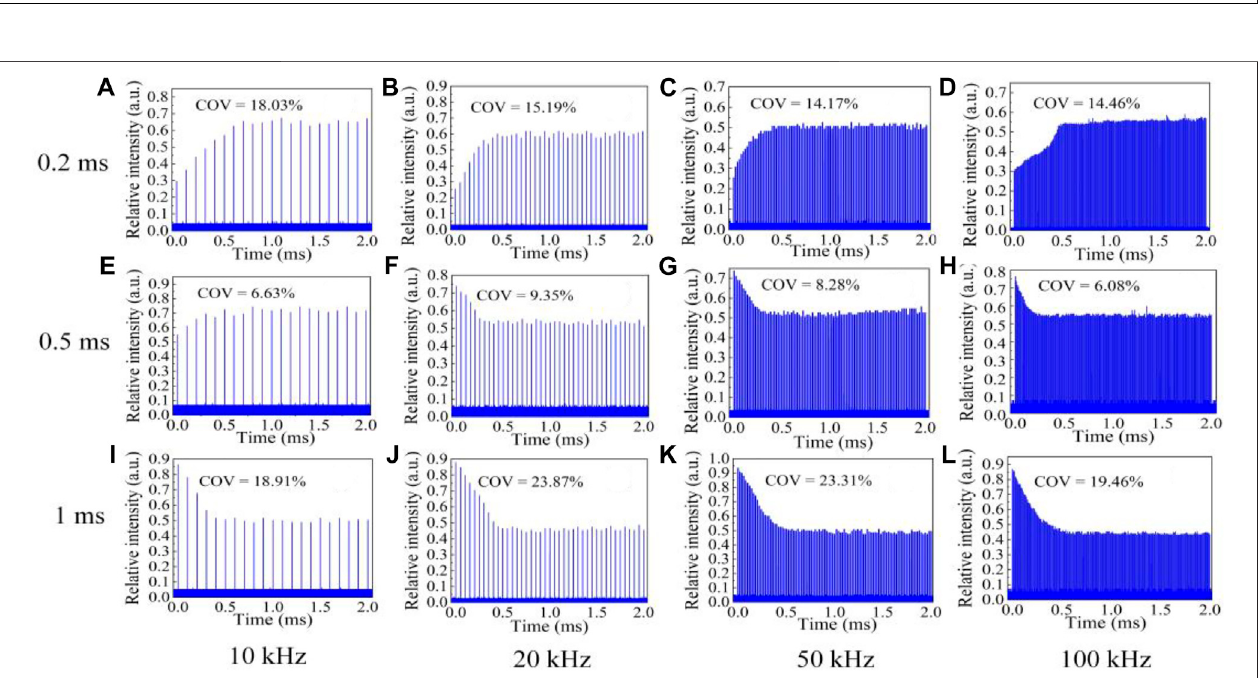
FIGURE 5 | Recorded input electric signal waveform and the output single-pulse laser pro fi le at the 100 kHz repetition rate. (A) Input electric signal waveform with duration of10 ns. (B) Input electric signal pro fi le with duration of 100 ns. (C) Output single pulse laser with pulse duration of 10.8 ns. (D) Output single pulse laser with a pulse width of 98 ns.